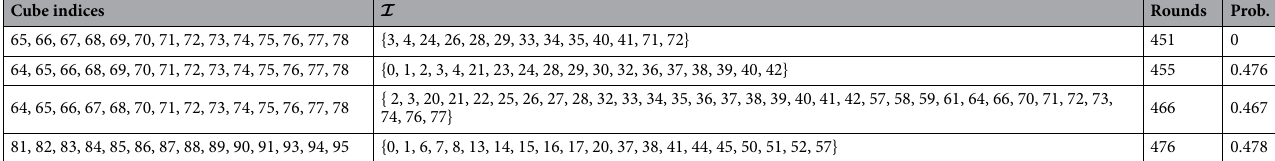
Table 3. Weak-key attacks for more than 450 rounds. Constraints are k i = 1 for i ∈ I . Fourth column represents the probability of the superpoly being